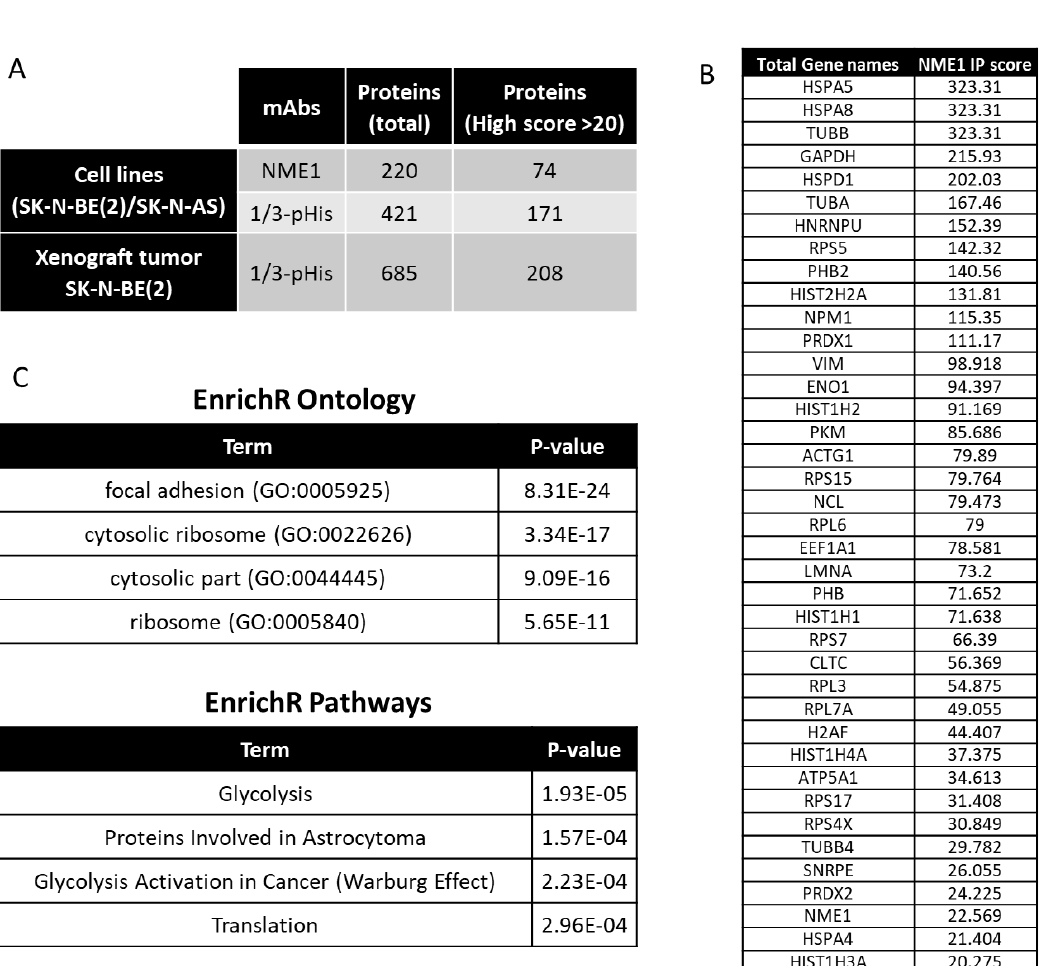
Figure 7. Intracellular pathways associated with NME1 in neuroblastoma. ( A ) Numbers of proteins identified by mass spectrometry from NME1/2 or 1/3-pHis pull-down experiments using a pool of SK-N-BE(2) and SK-N-AS neuroblastoma cell lines or orthotopic xenograft neuroblastoma tumors. ( B ) Neuroblastoma cell lysates were immunoprecipitated using antibodies to NME1 or 1/3-pHis, and isolated proteins were analyzed by mass spectrometry. Proteins identified in all three enrichments with an enrichment score derived from the interaction with NME1 higher than 20 are listed (a complete list and matching comparison of the proteins identified among the three different pull-down experiments are provided as a supplementary file). ( C ) 59 identified potential NME1 substrates were subjected to pathway analysis using EnrichR (https://amp.pharm.mssm.edu/Enrichr/) [36]. The top four identified pathways (using the Elsevier pathway collection) and gene ontology